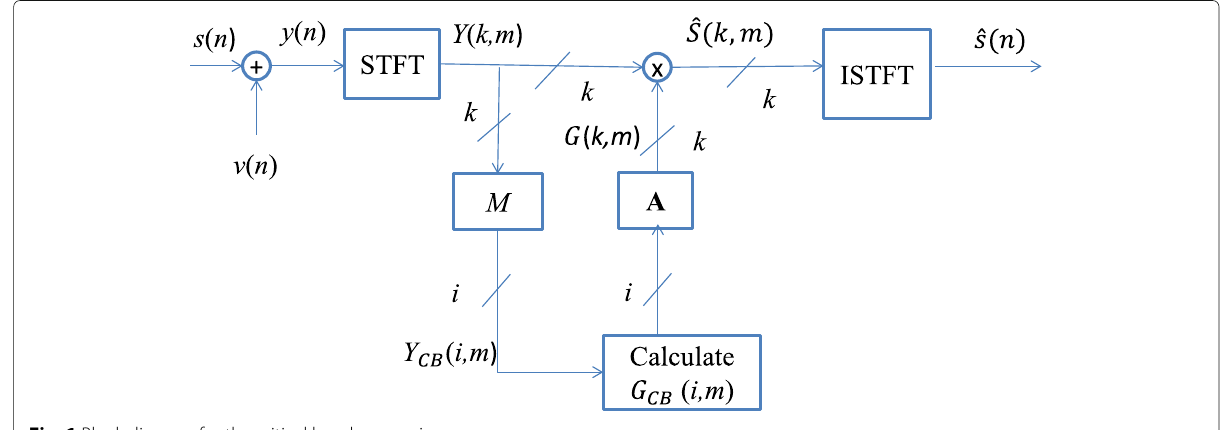
Fig. 1 Block diagram for the critical band